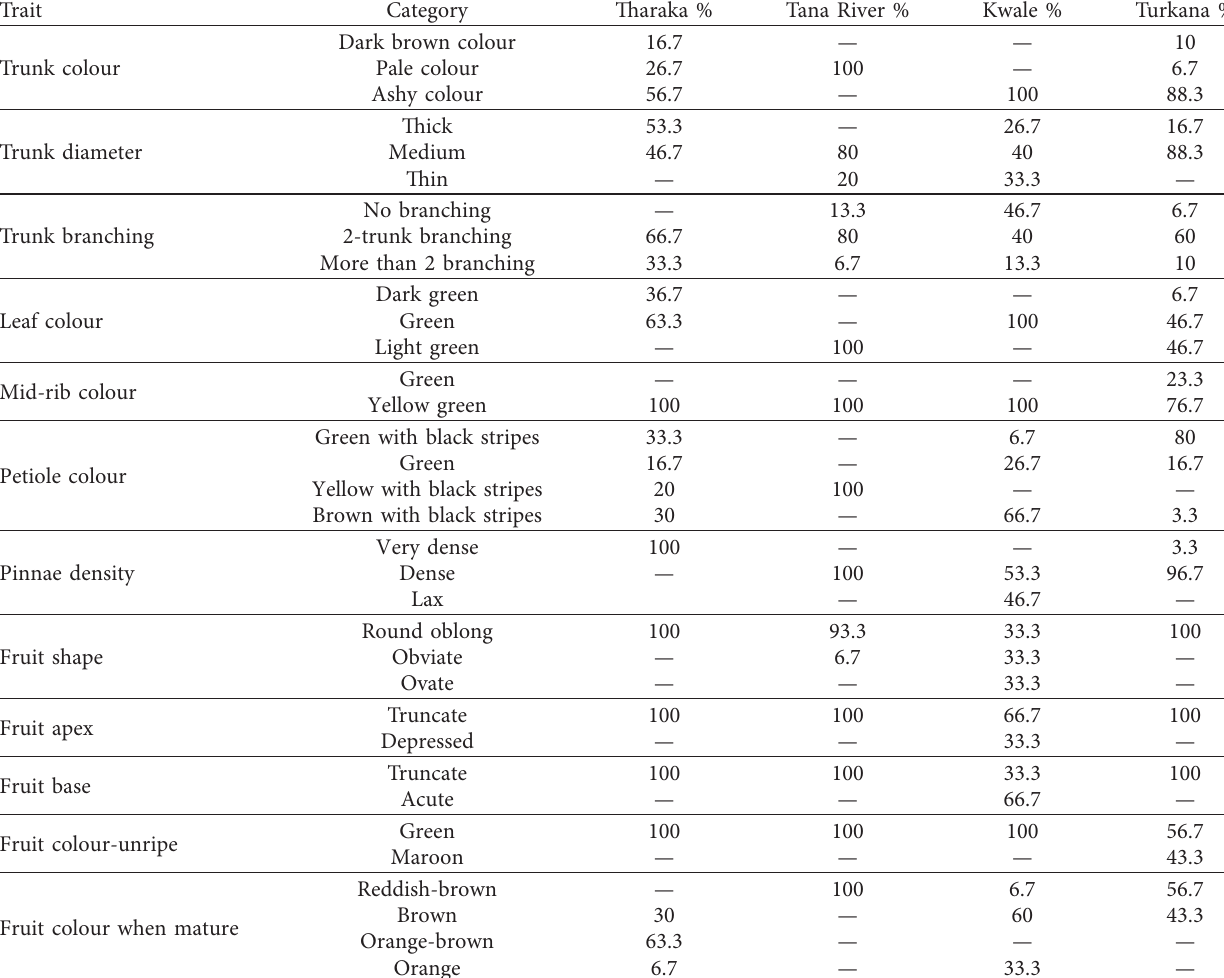
Table 6: Fruit and vegetative qualitative traits of Kenyan doum palm